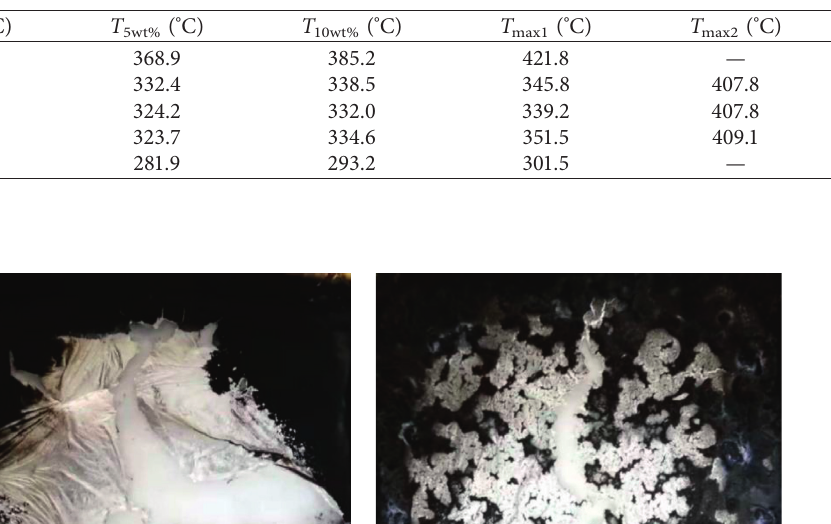
Table 3: TGA results of HIPS and the FR-HIPS.